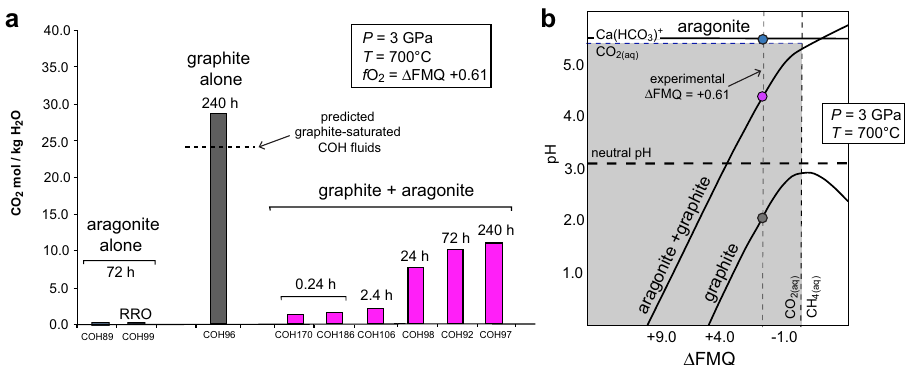
Fig. 2 Experimental CO 2 contents and thermodynamic modelling of fl uids. a CO 2 concentration (molality) in experimental aqueous fl uids interacting with (i) aragonite-only (blue), (ii) graphite-only (grey) and (iii) graphite + aragonite (magenta). Typical analytical uncertainty is 1 mol%. Dashed line: CO 2 content predicted by thermodynamic modelling of graphite-saturated COH fl uids. Run duration (h) is shown at the top of each bar. RRO: run buffered by Re – ReO 2 ( Δ FMQ ≈ + 2) instead of ferrosilite + magnetite + coesite; b f O 2 vs. pH diagram at 3 GPa and 700 °C generated by thermodynamic modelling (Deep Earth Water model 26,28 ) of aqueous fl uids in equilibrium with aragonite-only (blue dot), graphite-only (grey dot) and aragonite + graphite (magenta dot). Black solid lines: saturation curves. Coloured dots: experimental conditions at f O 2 buffered by ferrosilite + magnetite + coesite. Grey fi eld: CO 2(aq) is the dominant carbon-bearing species; it is adjacent to Ca(HCO 3 ) + -dominated fi eld at higher pH and to CH 4(aq) -dominated fi eld at lower f O 2 values. Neutral pH is shown for reference with a dashed line. Calculations are performed at 3 GPa, 700 °C and f H 2 buffered by ferrosilite + magnetite + coesite + H 2 O (equivalent to log ( f O 2 /1 bar) = − 13.36; Δ FMQ = +